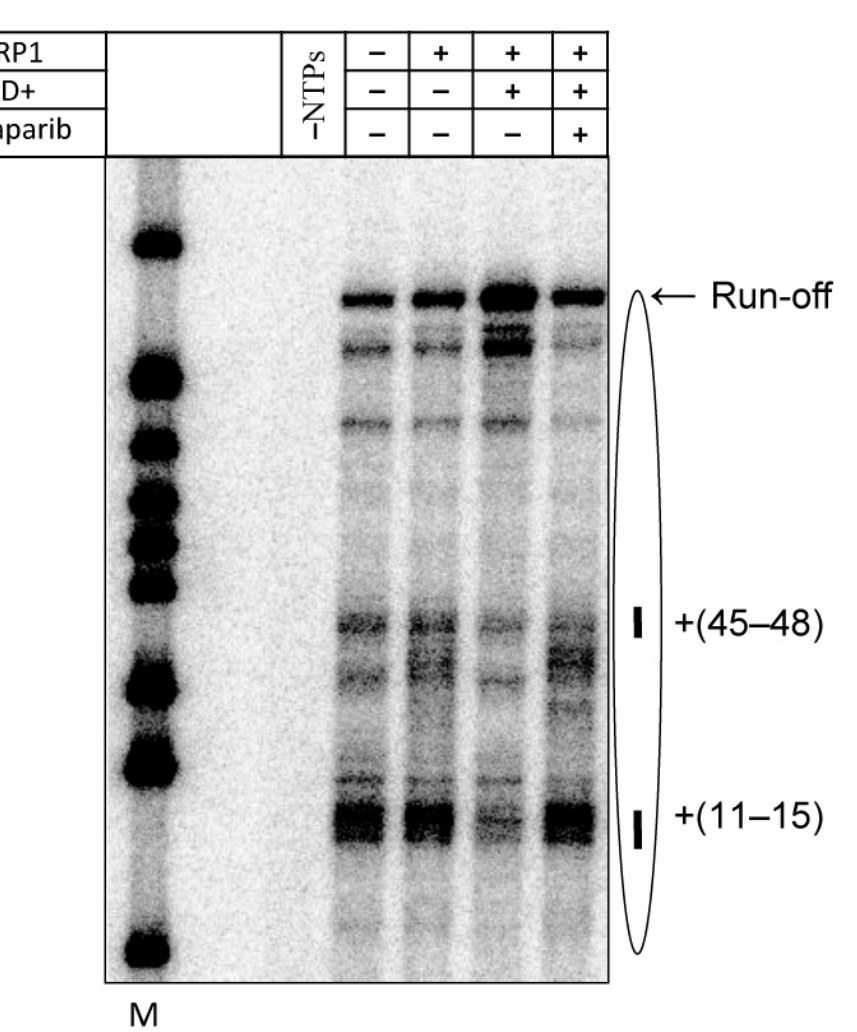
Figure 5. Anti-cancer drug olaparib strongly inhibits PARP1-dependent transcription through a nucleosome. PARP1 was pre-incubated in the presence of olaparib and added to pre-formed yPol II elongation complexes EC-80. Then 603 nucleosomes were transcribed in the presence or in the absence of PARP1 and/or NAD+, as described in Figure 1a,b.